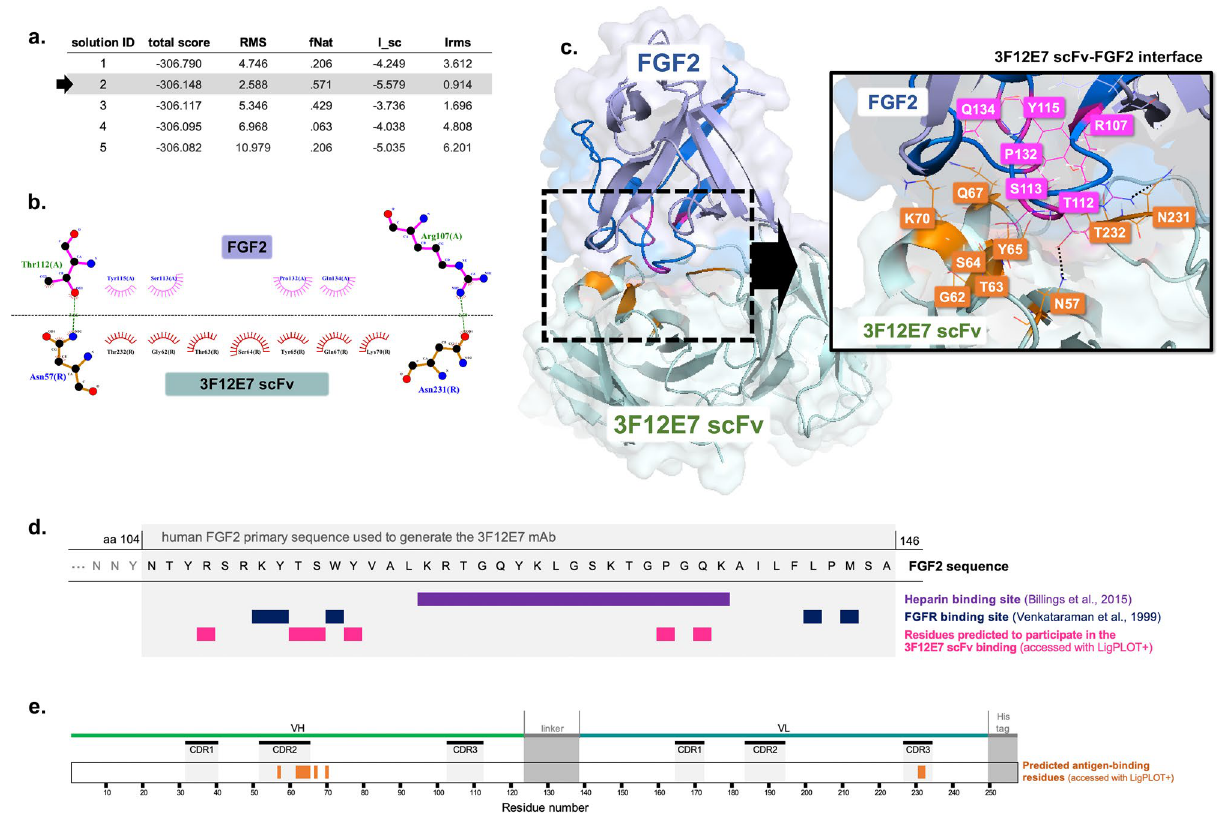
Figure 4. Prediction of 3F12E7 scFv binding to FGF2. ( a ) Metrics of the top-ranked 5 poses found by molecular docking between FGF2 (PDB ID: 1bfg) and 3F12E7 scFv with the Rosetta server. Based on CAPRI criteria, solution ID #2 was chosen for interaction analyses. ( b ) LIGPLOT + diagram of the residues interacting across the 3F12E7 scFv-FGF2 interface. 3F12E7 scFv and FGF2 residues are labeled brown and magenta, respectively. Hydrophobic interactions are represented by arc with spokes and hydrogen bonds are indicated by dashed green lines. Hydrogen bonds were detected between R107 and T112 of FGF2 and N57 and N231 of the scFv entity, respectively. ( c ) 3D representation of the 3F12E7 scFv-FGF2 putative complex. FGF2 and 3F12E7 scFv residues found by LIGPLOT + analyses are labeled magenta and orange, respectively. Hydrogen bonds are indicated by dashed lines. In dark blue, it is highlighted the FGF2 amino acid sequence (residues 104–146) used for the generation of the anti-FGF2 3F12E7 mAb, as reported 6 . Within this segment, the residues predicted to interact with 3F12E7 scFv are schematically indicated on ( d ), along with the heparin and FGFR binding sites. ( e ) Localization of the putative FGF2-contacting residues and the Paratome CDRs in the 3F12E7 scFv